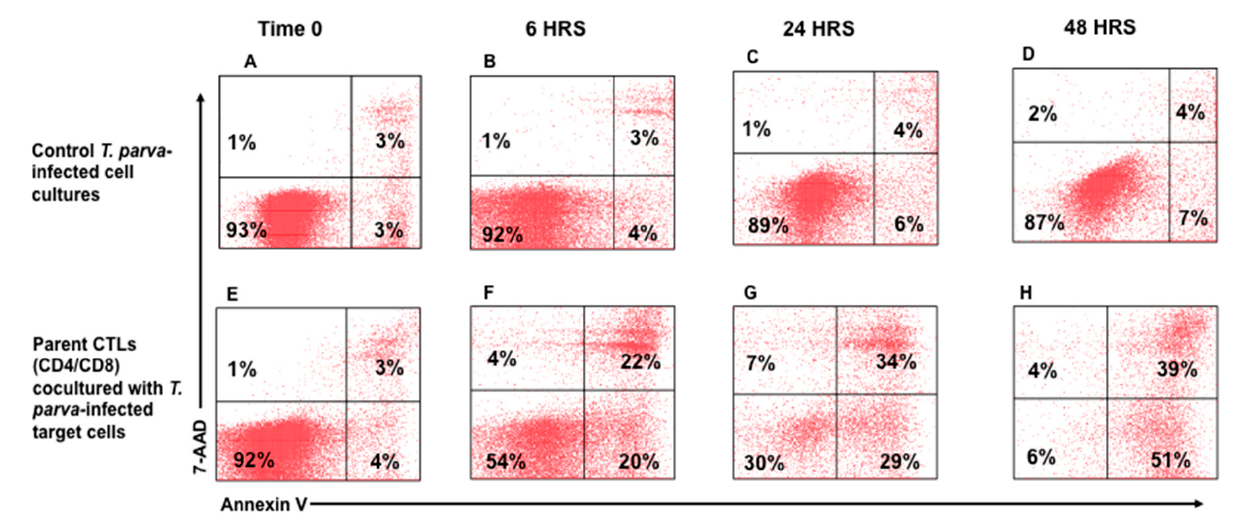
Figure 3. Detection of apoptotic and dead T. parva -infected target cells in preparations incubated with T. parva- specific CD4 + and CD8 + T cells. Representative preparation of infected target cells incubated alone ( A – D ) and with T. parva- specific stimulated CD4 + and CD8 + T-cell cultures ( E – H ) for 0, 6, 24, and 48 h. These results demonstrate that the proportion of apoptotic and dead infected target cells increases over time when incubated with T. parva -specific effector T cells. The lower left quadrants highlighted in green show the relative temporal changes in the proportion of viable target cells remaining at different time points following incubation with effector T cells. Little or no change in cell viability was evident in the culture of target cells maintained concurrent with the time target cells were co-cultured with parent cultures of effector cells containing CD4 and CD8 T-cell subsets. The results show there was a time dependent reduction in viable target cells. This was related to the time taken for the CTLs to deliver their lethal ‘kiss of death’ and move on to the next target cell.